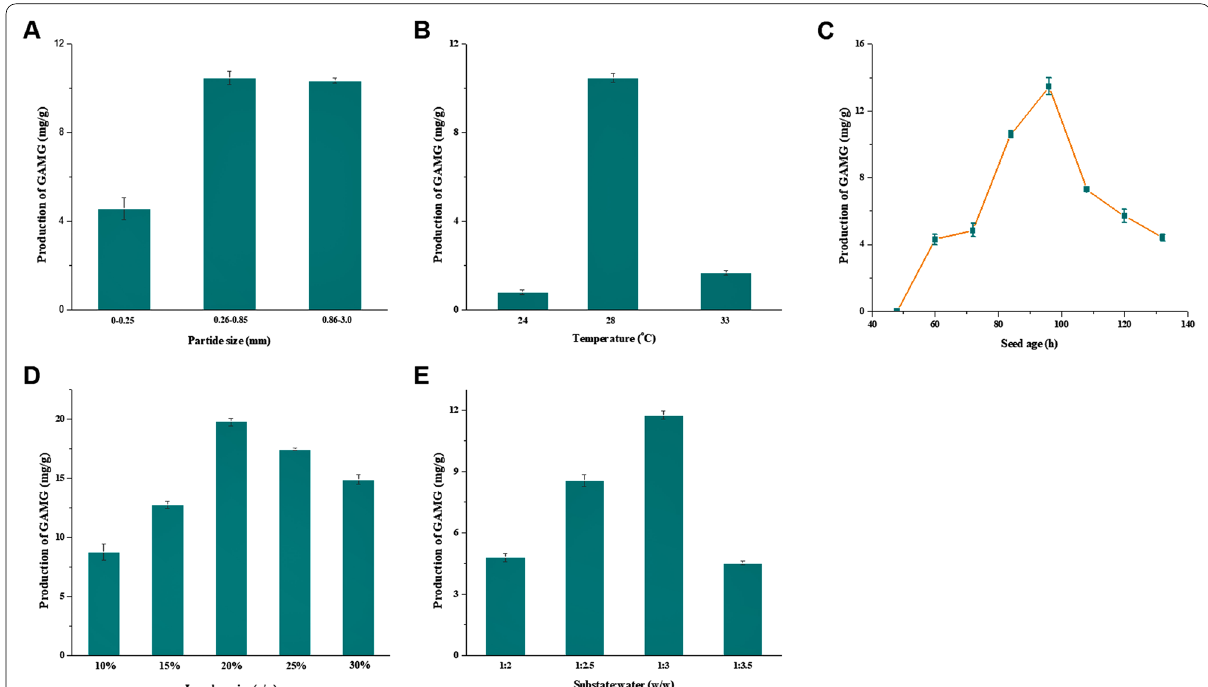
Fig. 2 Optimization of fermentation conditions, including 0–0.25, 0.26–0.85, and 0.86–3.0 mm of particle size assessed at 28 °C, 96 h of seed age, 15% inoculum and substrate:water 1:3 ( A ), 24 °C, 28 °C, and 33 °C of temperature assessed at 96 h of seed age, 15% inoculum, = substrate:water 1:3 and 0.26–0.85 mm of particle size ( B ), 48, 60, 72, 84, 96, 108, 120, and 132 h of seed age assessed at 28 °C, 15% inoculum, = substrate:water 1:3 and 0.26–0.85 mm of particle size ( C ), 15%, 20%, 25%, 30%, 35%, and 40% of inoculum size assessed at 28 °C, 96 h of seed age, = substrate:water 1:3 and 0.26–0.85 mm of particle size ( D , v/w), and 1:2, 1:2.5, 1:3, 1:3.5 of substrate:water assessed at 28 °C, 15% inoculum, 96 h of = seed age and 0.26–0.85 mm of particle size ( E